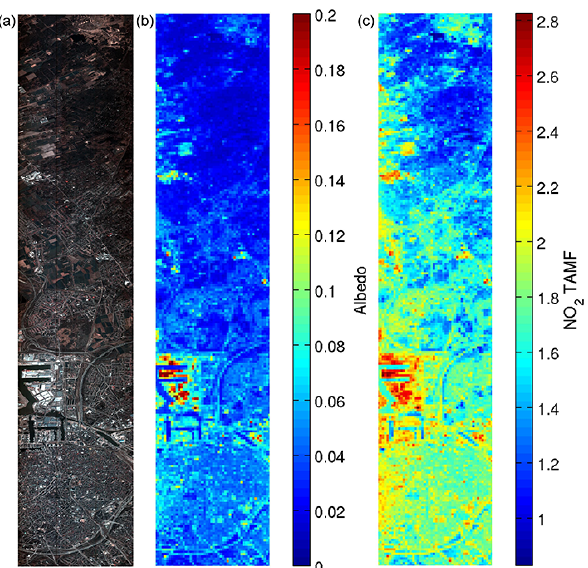
Figure 9. (a) APEX true colour composite, (b) APEX albedo level 2 product and (c) computed TAMFs, for flight line eight of the Antwerp data set (15 April 2015). The strong dependency of the AMF on the albedo can be